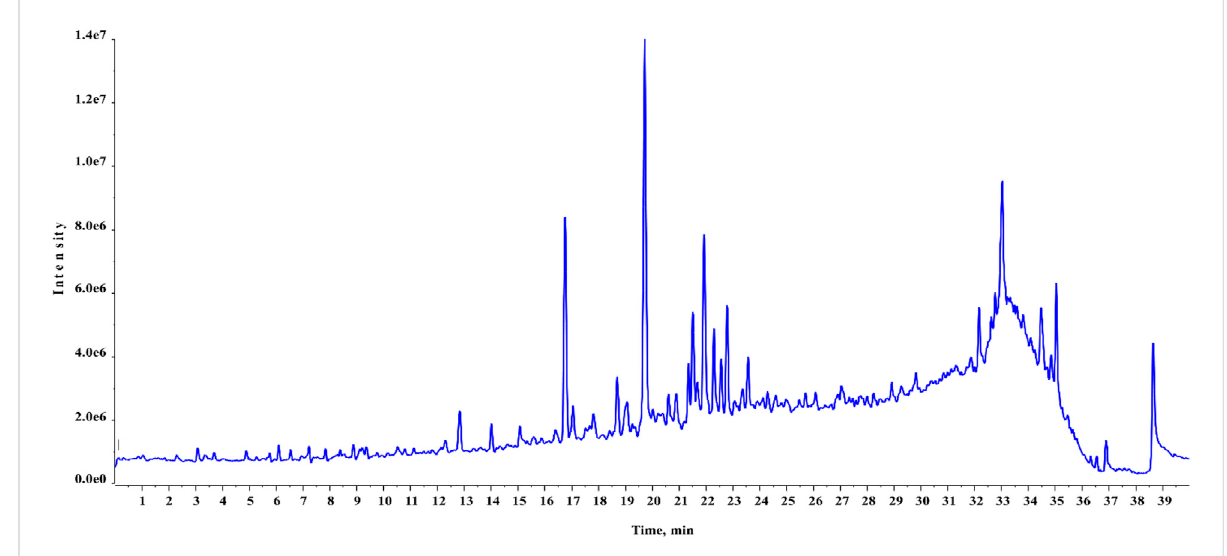
FIGURE 2 Total ionic chromatogram (TIC) of HAECA (positive mode in UPLC-Q-TOF-MS